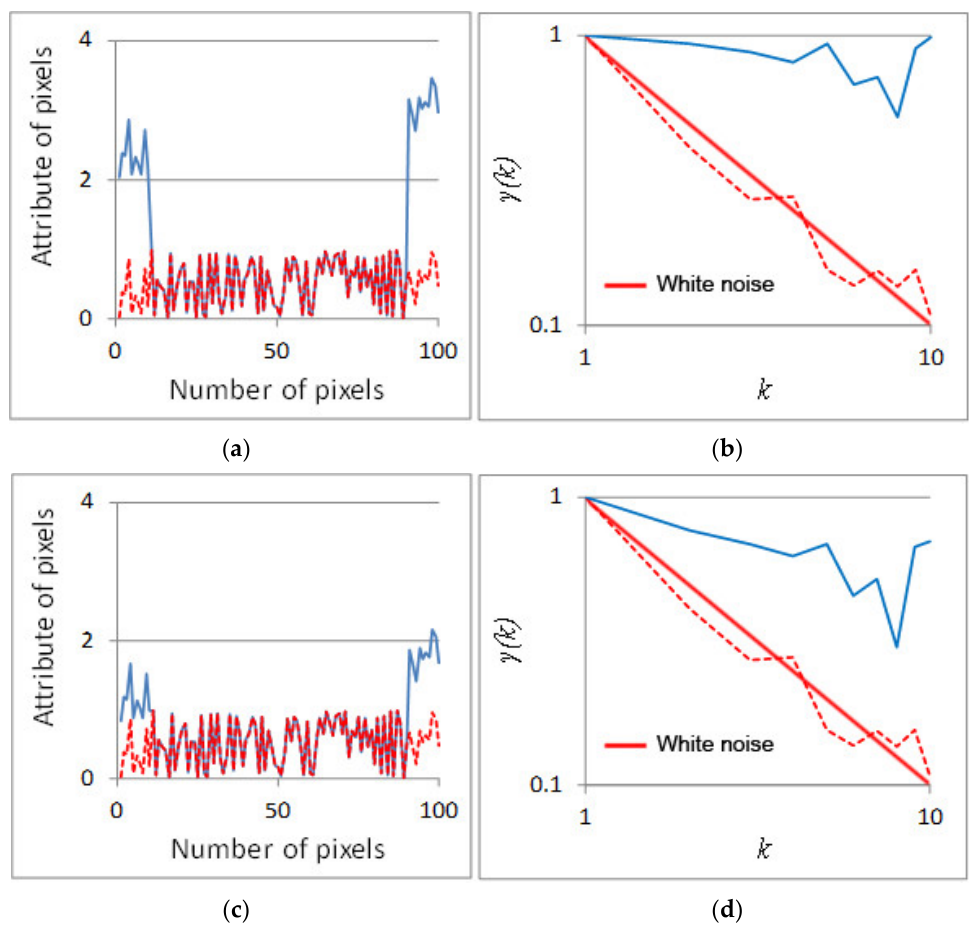
Figure 3. ( a , c ) Examples of data series with different statistical characteristics in one dimension. ( b , d ) Standardized climacograms of the data series shown in ( a , c ).